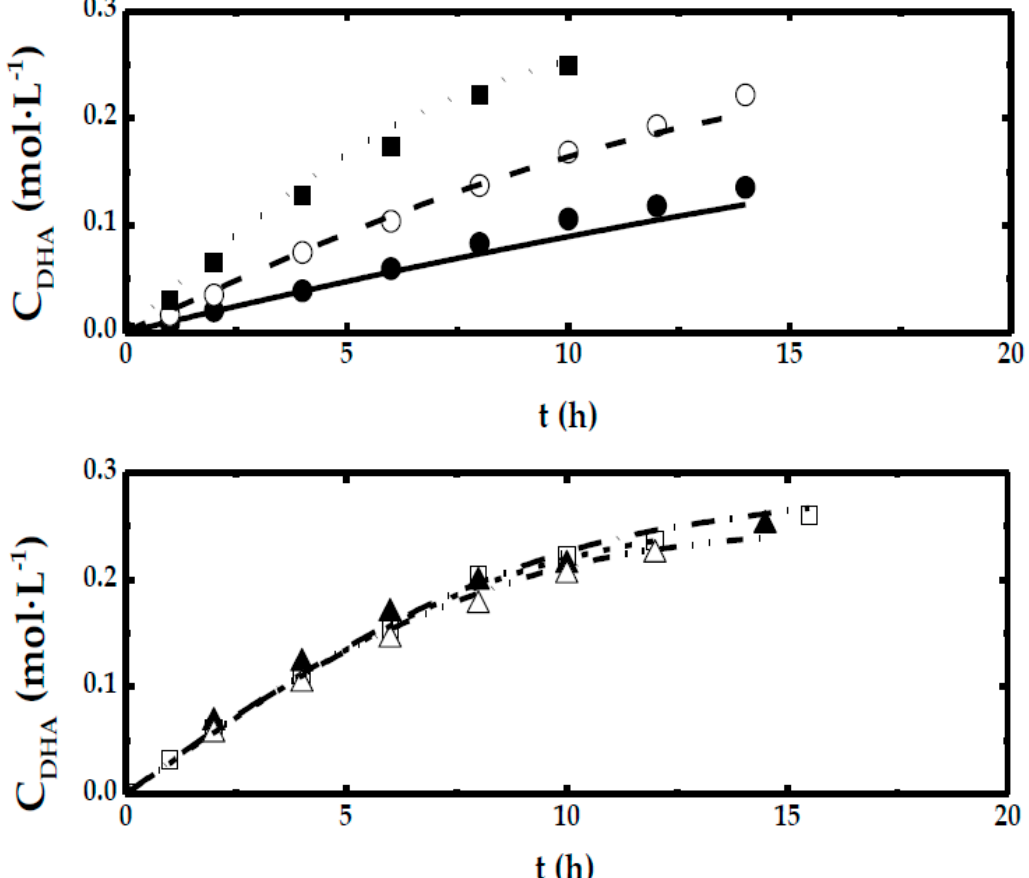
Figure 8. Reproduction of DHA concentration vs. time for runs 16 to 18 (carried out in shake flasks, (upper graphic) and for runs 22 to 24 (carried out in STBR, lower graphic). Runs in shake flasks conducted at 400 rpm of agitation and several biomass concentrations: 0.4 ( ● ), 0.5 ( ○ ), and 1.0 g·L − 1 ( ■ ). Runs carried out in STBR with a biomass concentrations of 0.5 g·L − 1 and several stirring speeds: 560 rpm ( □ ), 650 rpm ( ▲ ), and 750 rpm ( ∆ ). Points correspond to experimental results, and lines correspond to kinetic model simulation when the oxygen transport rate (OTR) is controlling the overall process rate. Model Equation (6). Table 5. Kinetic and statistical parameters calculated for high agitation experiments with the reaction rate control of the overall process rate. Runs 16 to 18 (shake flasks) and 22 to 24 (STBR). Model Equation (6). RMSE: residual mean square error, SQR: sum of residuals, SEE: standard error of estimates, VE: percentage of explained variance.